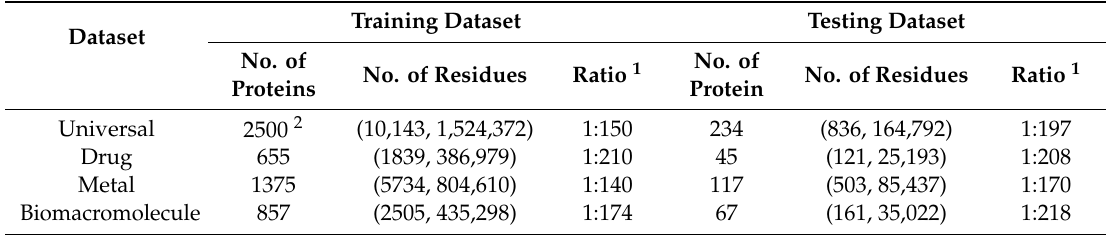
Table 6. The detailed composition of new built standard